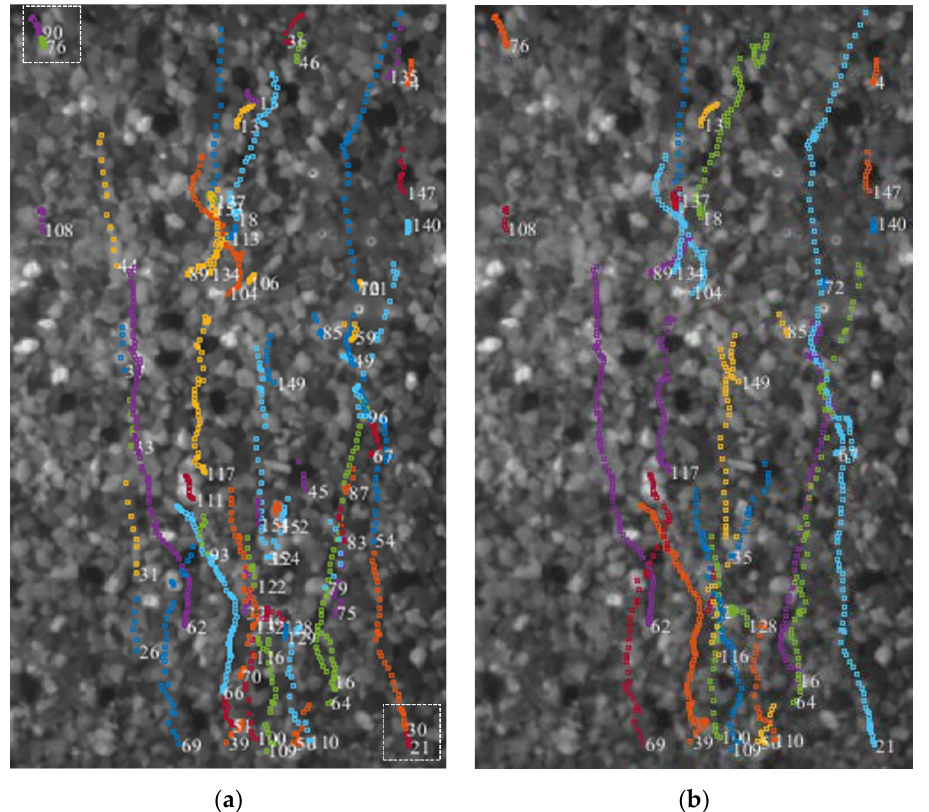
Figure 13. Particle tracking results by ( a ) new method without the third step; ( b ) new method; The different colors represent different trajectories.